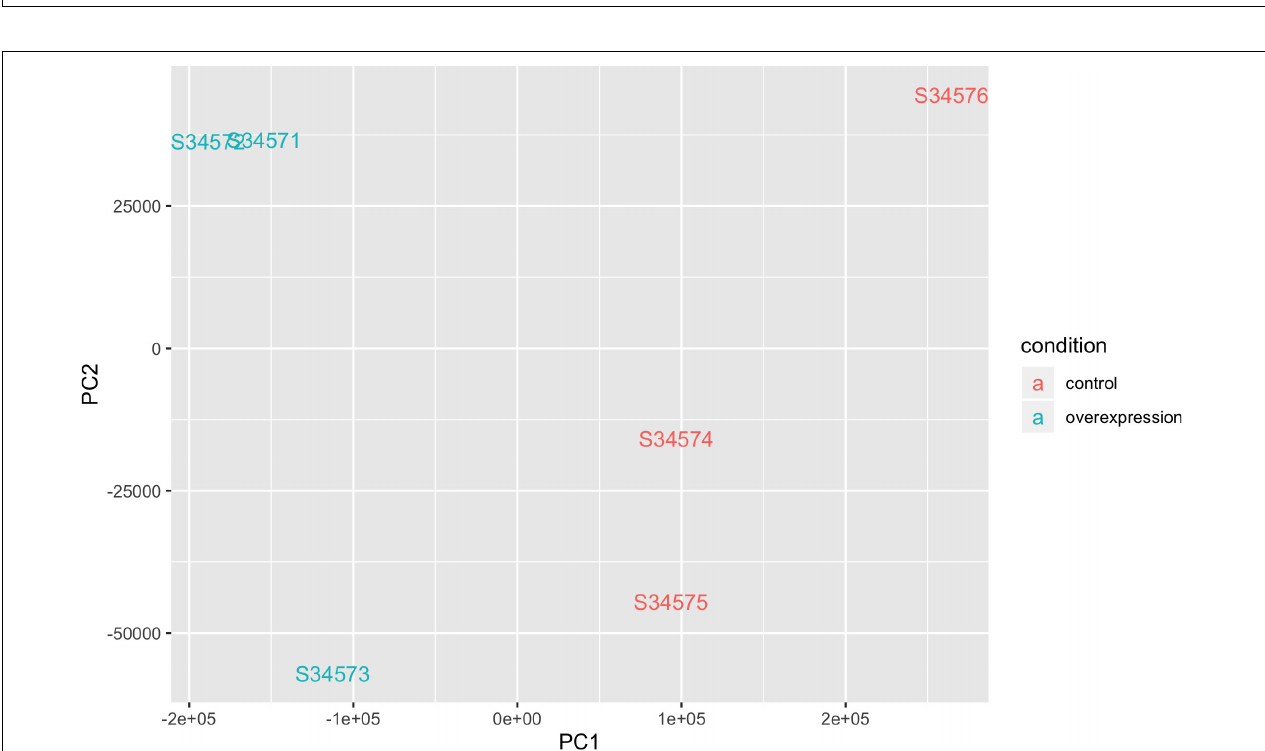
FIGURE 3 | Principle component analysis plot of RNA sequencing data of STK32B overexpressed cells and empty-vector controls. Overexpressed cells shown in blue and controls shown in red.